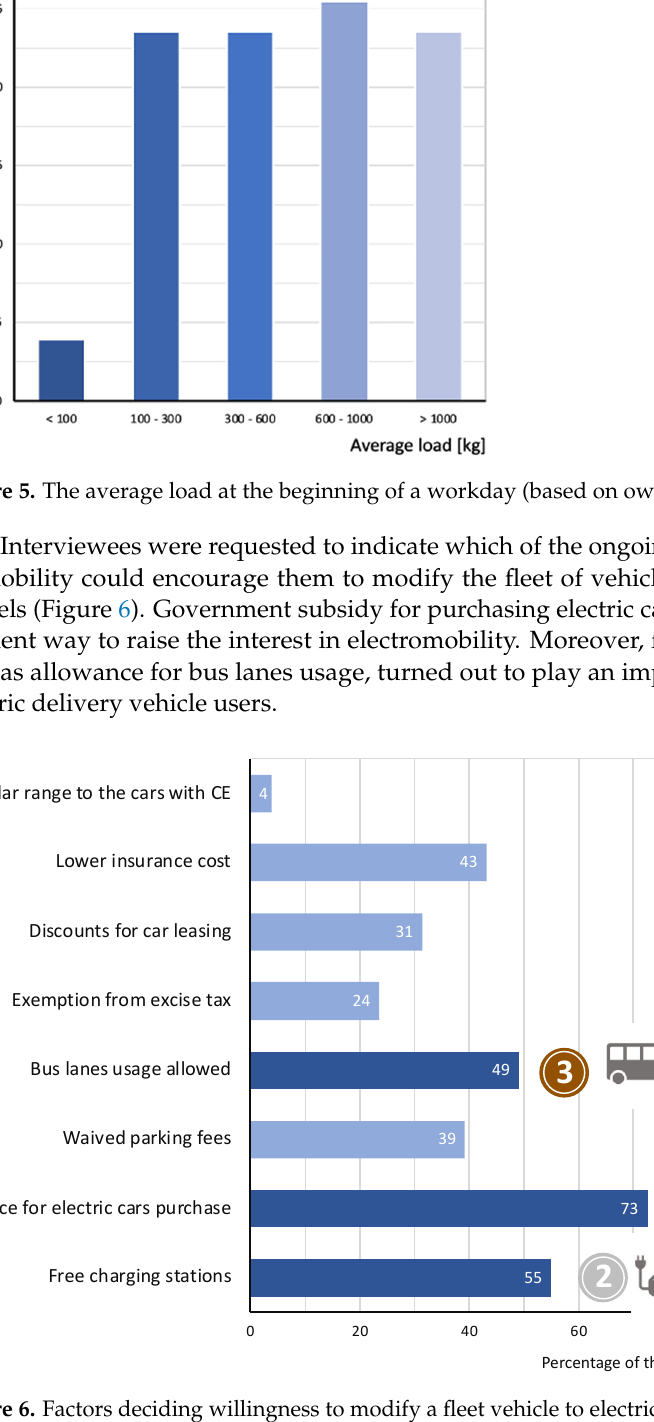
Figure 6. Factors deciding willingness to modify a fleet vehicle to electric-powered models (based on own survey).